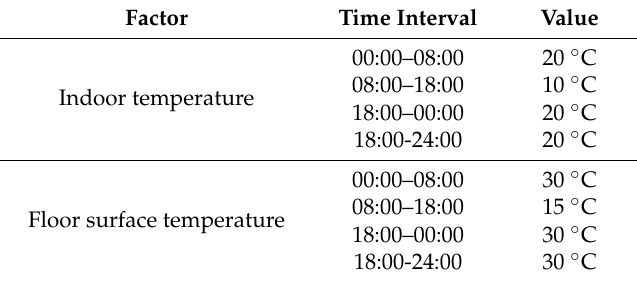
Table 8. Schedules of set points for indoor air and the floor